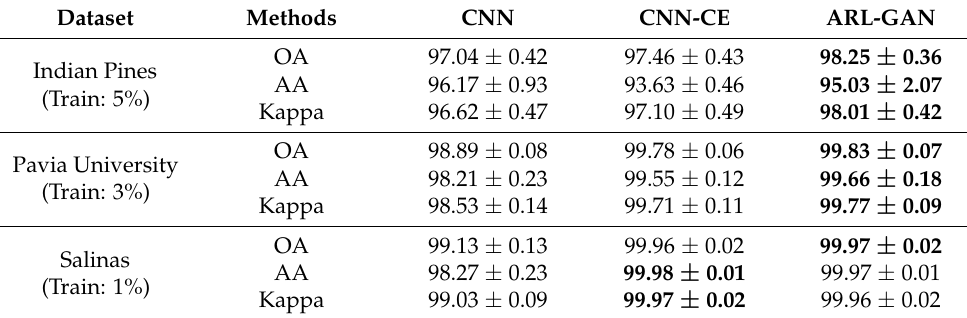
Table 7. Classification result of CNN, CNN-CE, and